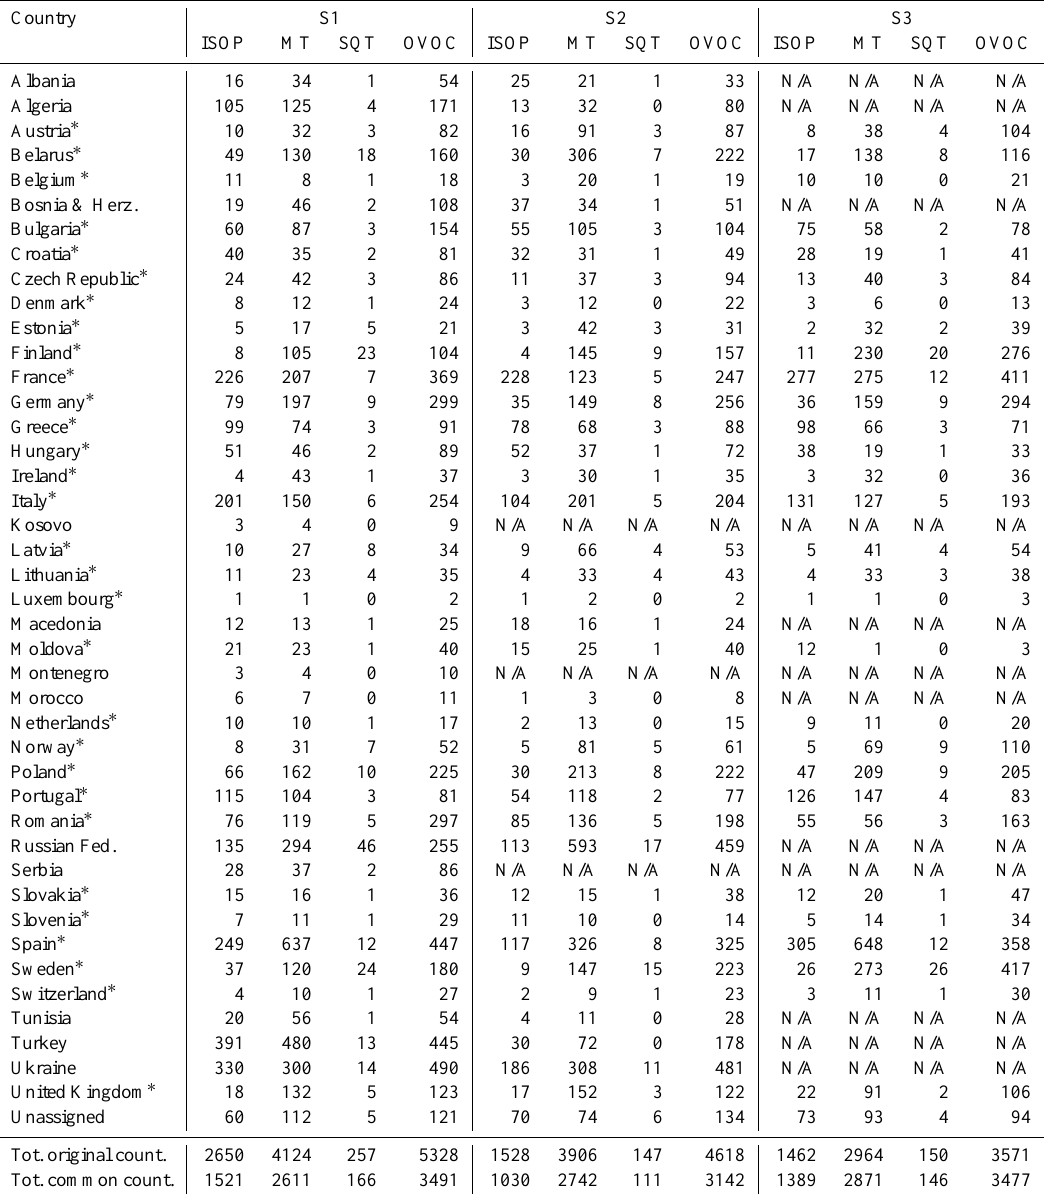
Table 1. Emission data by country (annual totals in Gg yr − 1 ) and overall totals. Common countries are marked with ∗ , these are the countries that are contained in all vegetation inventories (S1–S3). Some cells are not assigned to a country, these are mostly shore